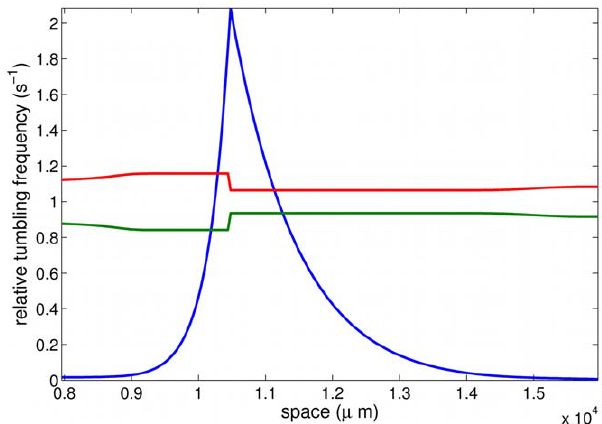
Figure 6. Relative tumbling frequencies (at the mesoscopic scale) obtained from the numerical experiment described in Fig. 3: the tumbling probability is higher when moving to the left (upper red line) at the back of the pulse, whereas the tumbling probability when moving to the right is lower (lower green line), resulting in a net ux towards the right, as the pulse travels (see Fig. 3). Notice that these two curves are not symmetric w.r.t. to the basal rate 1, but the symmetry defect is of lower order. The peak location is also shown for the sake of completeness (blue line).